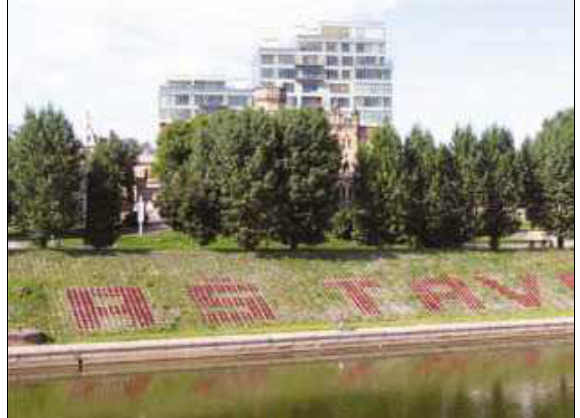
14 pav. Dau­giabu­tis gyvenamasis kompleksas „Delfinas“ su­ komercinėmis patalpomis ir požeminiais garažais Ju­ozapavičiau­s g. (archit. k. Pempė, L. Jančytė, e. kirdu­lienė) Fig. 14. complex “Delfinas“ with blocks of flats, the commercial premises and parkings in Ju­ozapavičiu­s st. a­rch. k. Pempė, L. Jančytė, e. kirdu­lienė